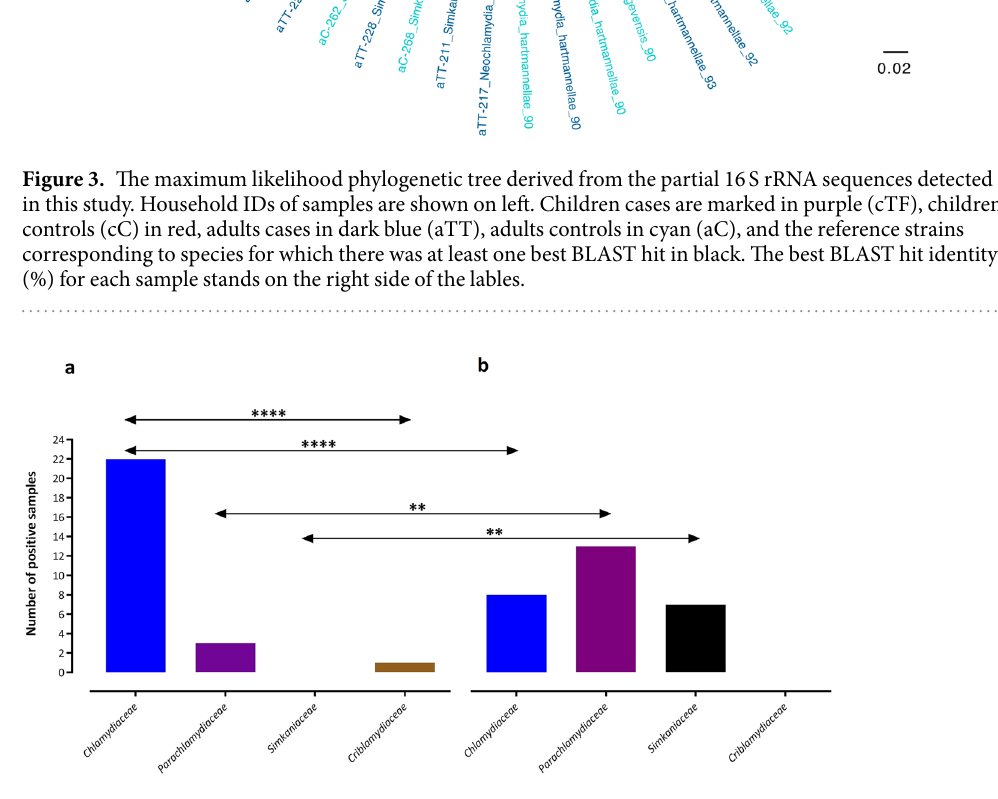
Figure 4. Abundance of 16 S rRNA gene sequences in the ocular samples taken from Al Qadarif-Sudan classified at the family-level in the Chlamydiae based on the closest BLAST hit. ( a ) Distribution of sequences obtained from children, assigned to members of chlamydial families. ( b ) Distribution of sequences obtained from adults, assigned to members of chlamydial families. The statistical significance is indicated as follows: ** p < 0.01, and **** p <